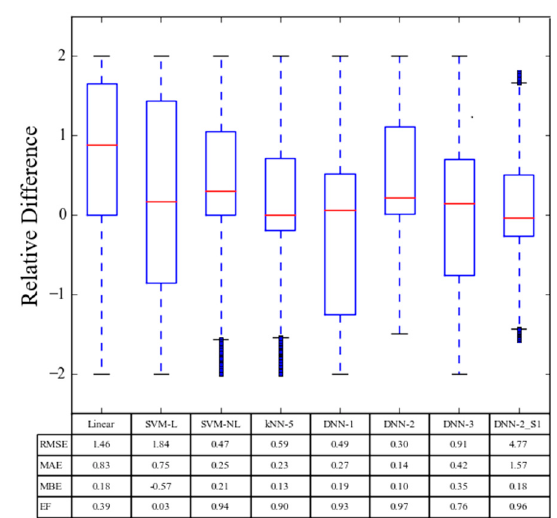
Figure 8. Statistical parameters associated with the trained data-driven models of runoff quantity and quality. The root mean square error (RMSE), mean bias error (MBE), mean absolute error (MAE), model efficiency (EF), and a box plot of the relative error distribution for data-driven models are given. The units of RMSE, MBE, and MAE of the runoff quantity and quality are liters and g, respectively. The upper and lower boundaries of the boxes show the 75th and 25th percentile, the whiskers of the box plot show the maximum and minimum values, and the red line within the box is the median value. Blue dot symbols indicated the outliers.